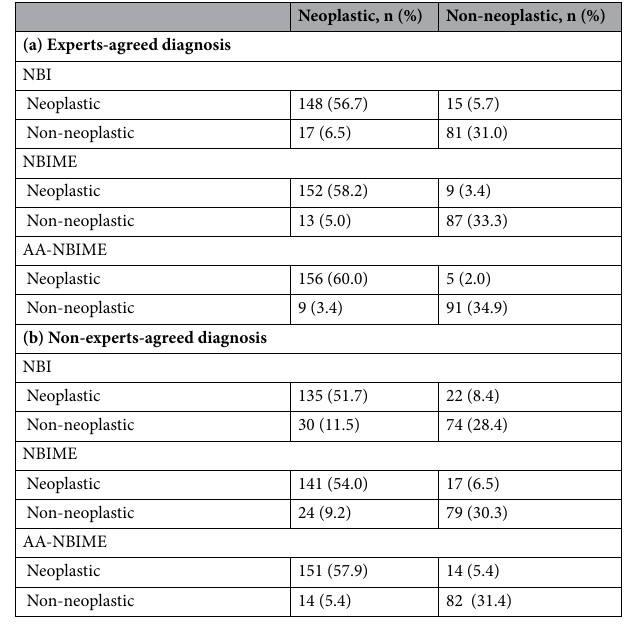
Table 2. Correlation between (a) “experts-agreed diagnosis”, (b) “non-experts-agreed diagnosis” for each modality and histopathologic type.